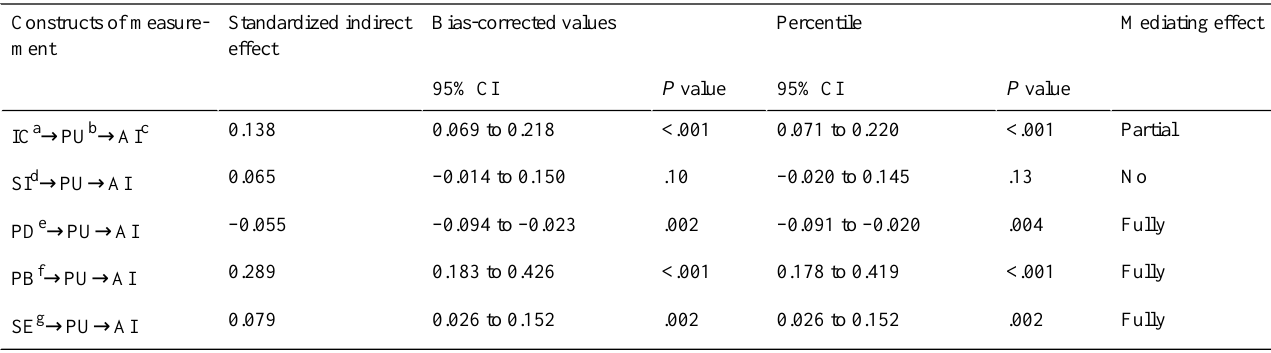
Table 7. Mediation effect